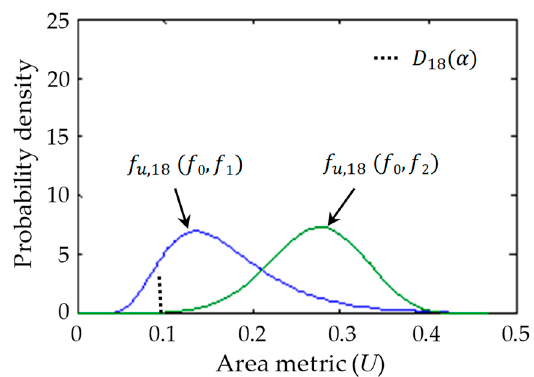
Figure 6. PDFs of the area metric ( U ) for experimental conditions I and II. Table 2. Calculated type II errors.